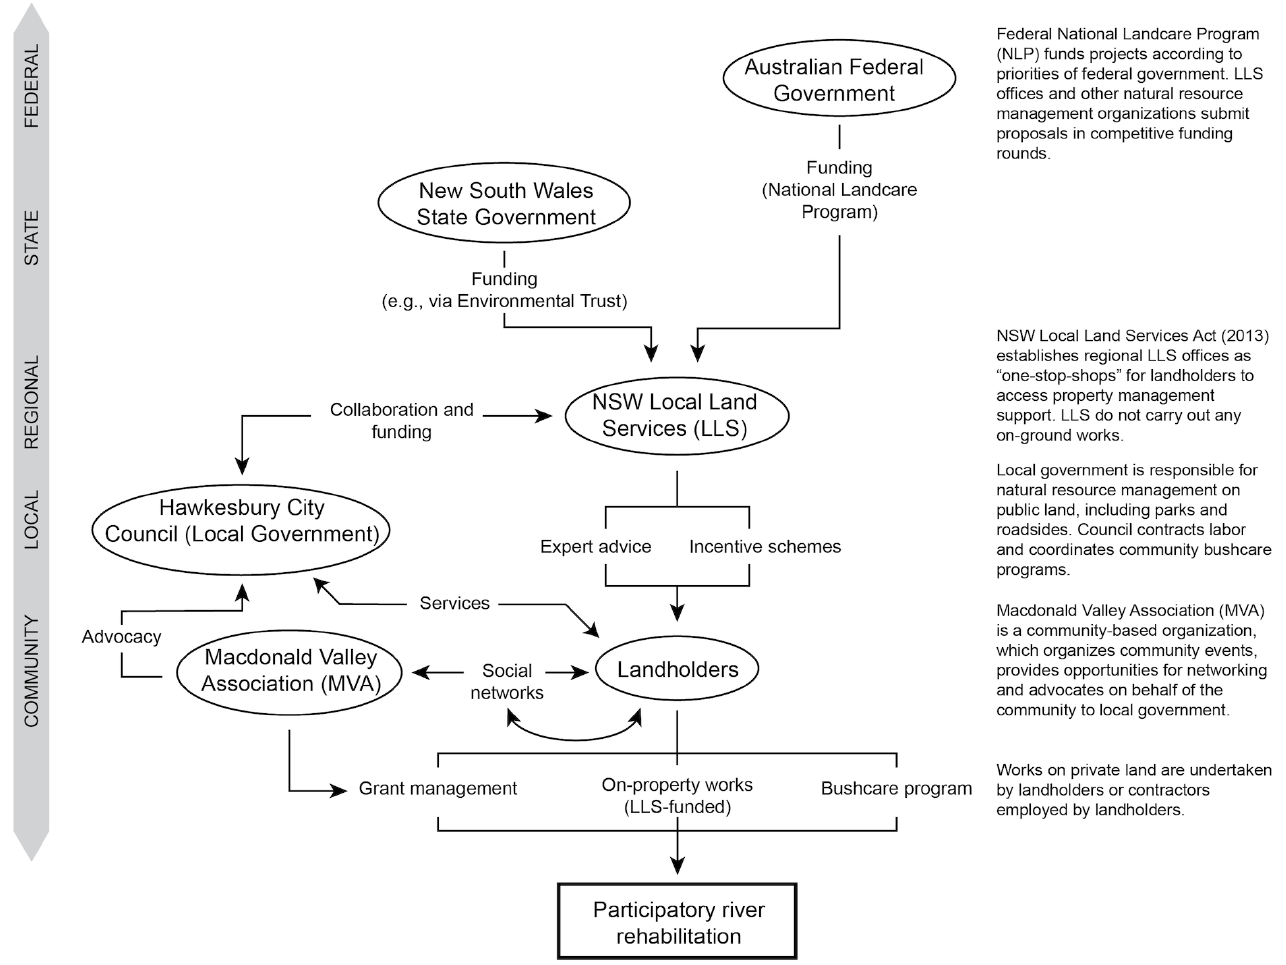
Fig. 2 . Roles of organizations and groups involved in the participatory rehabilitation of Macdonald River, where New South Wales Local Land Services exist as a middle-ground nexus for funding and coordination of works. Ovals contain groups of actors in river management, connected by lines describing the primary relationships between